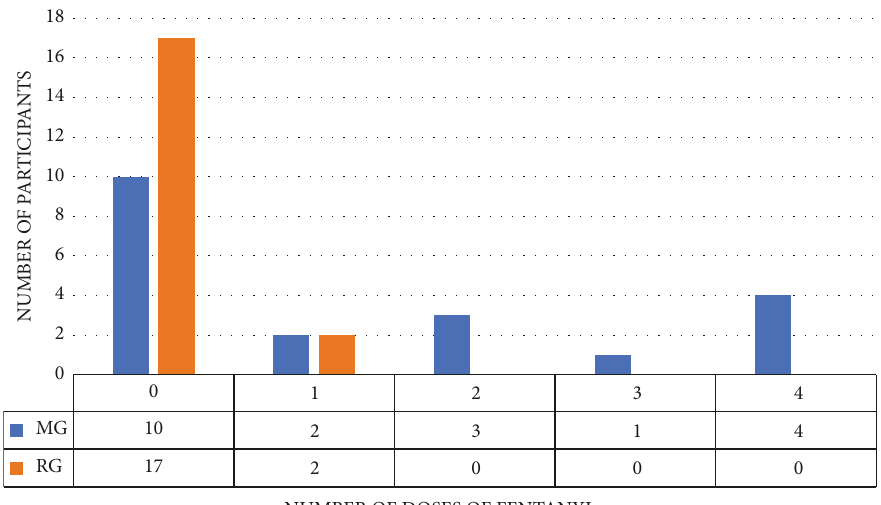
Figure 2: Comparison of fentanyl consumption between the groups. MG, magnesium sulfate group; RG, remifentanil